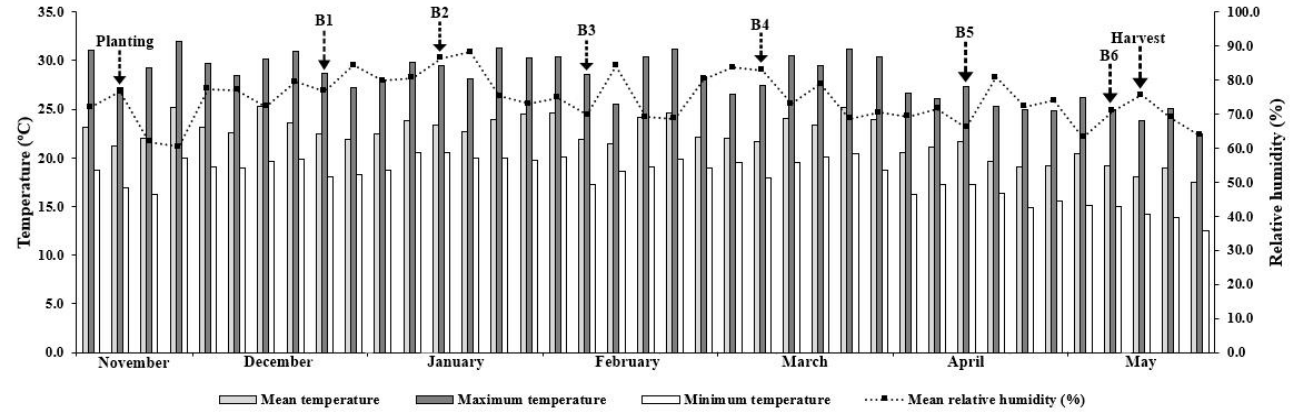
Figure 1. Mean, maximum, and minimum air temperature and average relative humidity inside the protected crop enclosure during the experimental period. B1: 1st biometric evaluation (BE); B2: 2nd BE; B3: 3rd BE; B4: 4th BE; B5: 5th BE, and B6: 6th BE.